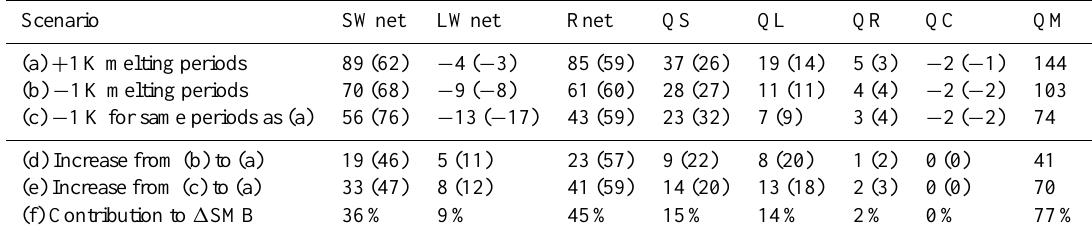
Table 9. Mean SEB terms (Wm − 2 ) during melting periods in the + 1K (a) and − 1K (b) perturbation runs of SEBpr. Also shown are mean SEB terms (Wm − 2 ) in the − 1K perturbation run, for the same periods as (a) , i.e. melting periods in the + 1K perturbation run (c) , and the increases (Wm − 2 ) between each scenario (d, e) . The percentage contribution of each flux to QM, or the increase in QM, is given in parentheses. The percentage contribution of each flux to (cid:49) SMB is given in the last row (f)